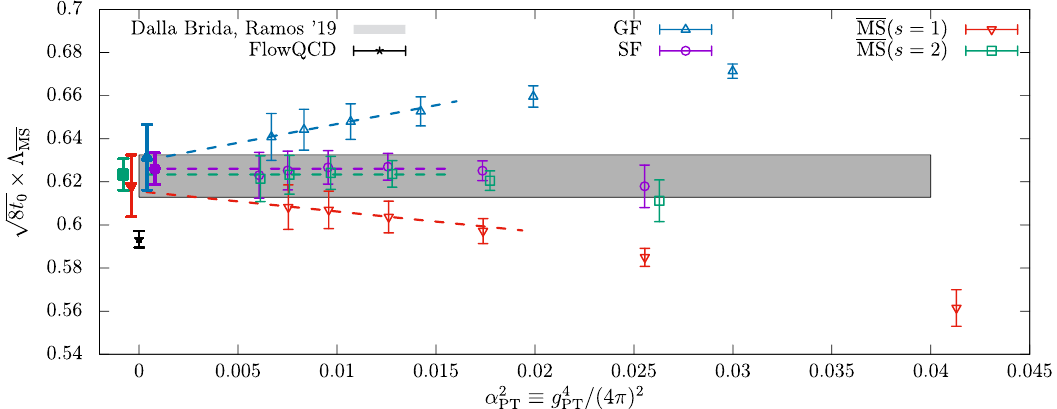
√ Fig. 11 The dimensionless product 8 t 0 × (cid:3) as a function of g PT bative matching (see text for more details). The gray band is the result MS (see Eq. (4.16)). The empty symbols represent the data of table 3 for of Ref. [13], while the data point labeled FlowQCD is the result of Ref. n = 0 ,..., 5, while the filled symbols are extrapolations g PT → 0 (shifted for better visibility) of the different approaches to the pertur-